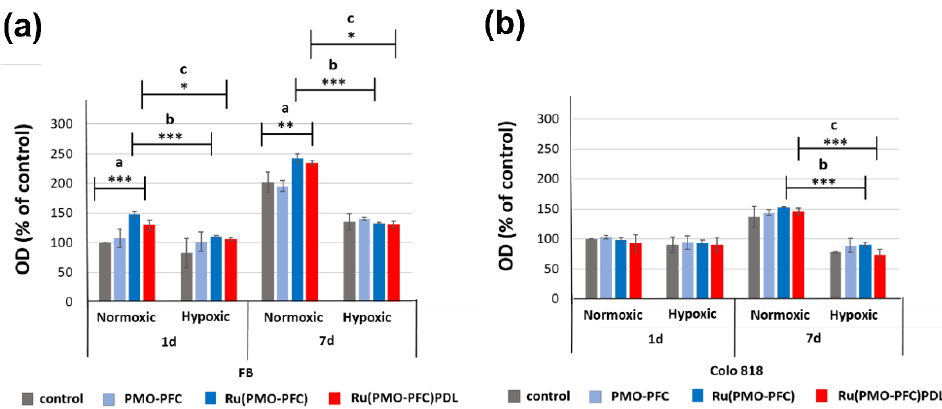
Figure 4. Absorbance (optical density) of the FB ( a ) and colo818 cells ( b ) on a culture plate (control), on a PMO-PFC-coated culture plate, on Ru(PMO-PFC)-coated culture plate, and Ru(PMO-PFC)PDL-coated culture plate under normoxic and hypoxic conditions at 1 and 7 d of incubation. ANOVA: p < 0.05 (*), p < 0.01 (**), p < 0.001 (***); a = significant difference between four groups, b = significant difference between the two groups (between normoxic and hypoxic value of Ru(PMO-PFC)) and c = significant difference between two subgroups (between normoxic and hypoxic value of Ru(PMO-PFC)PDL). The number of experiments is three.